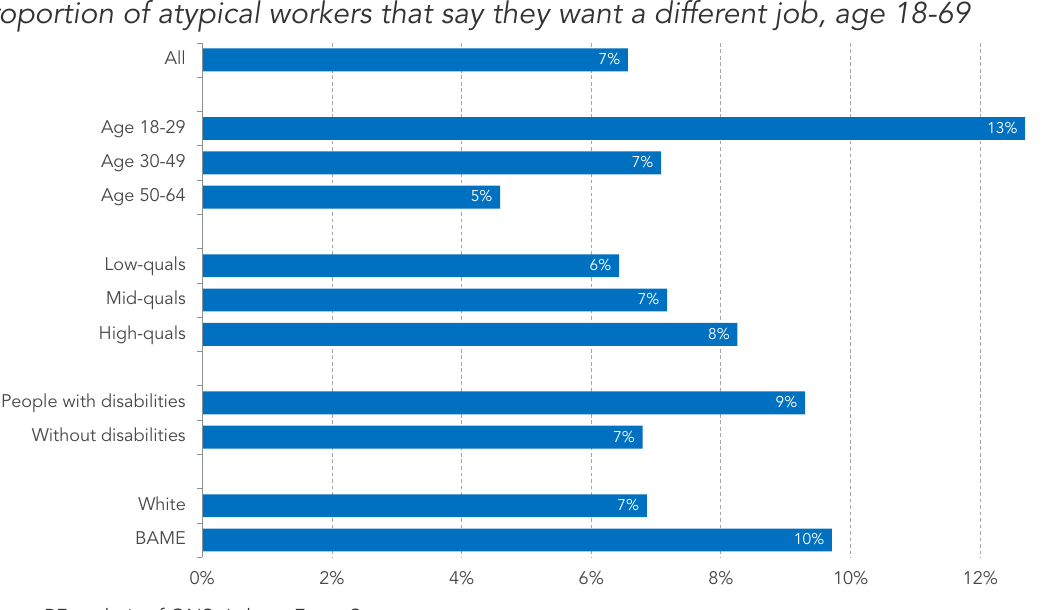
Source: RF analysis of ONS, Labour Force